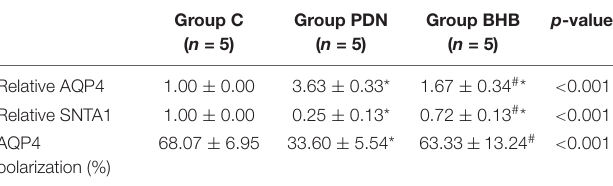
TABLE 2 | Immunofluorescence quantification and Western blot results obtained from the spinal